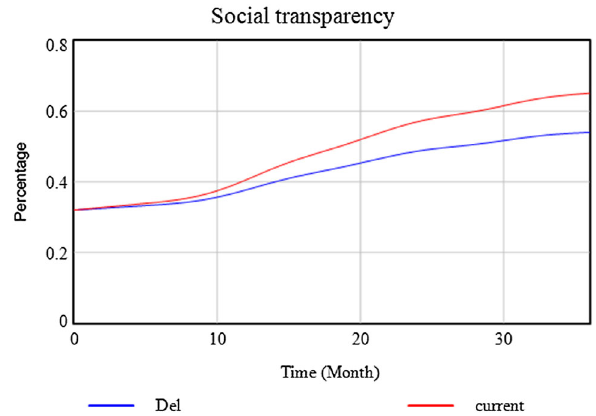
Fig. 6 Theeffectofremovingthelegalrequirementsrateonsocialtrans- parency